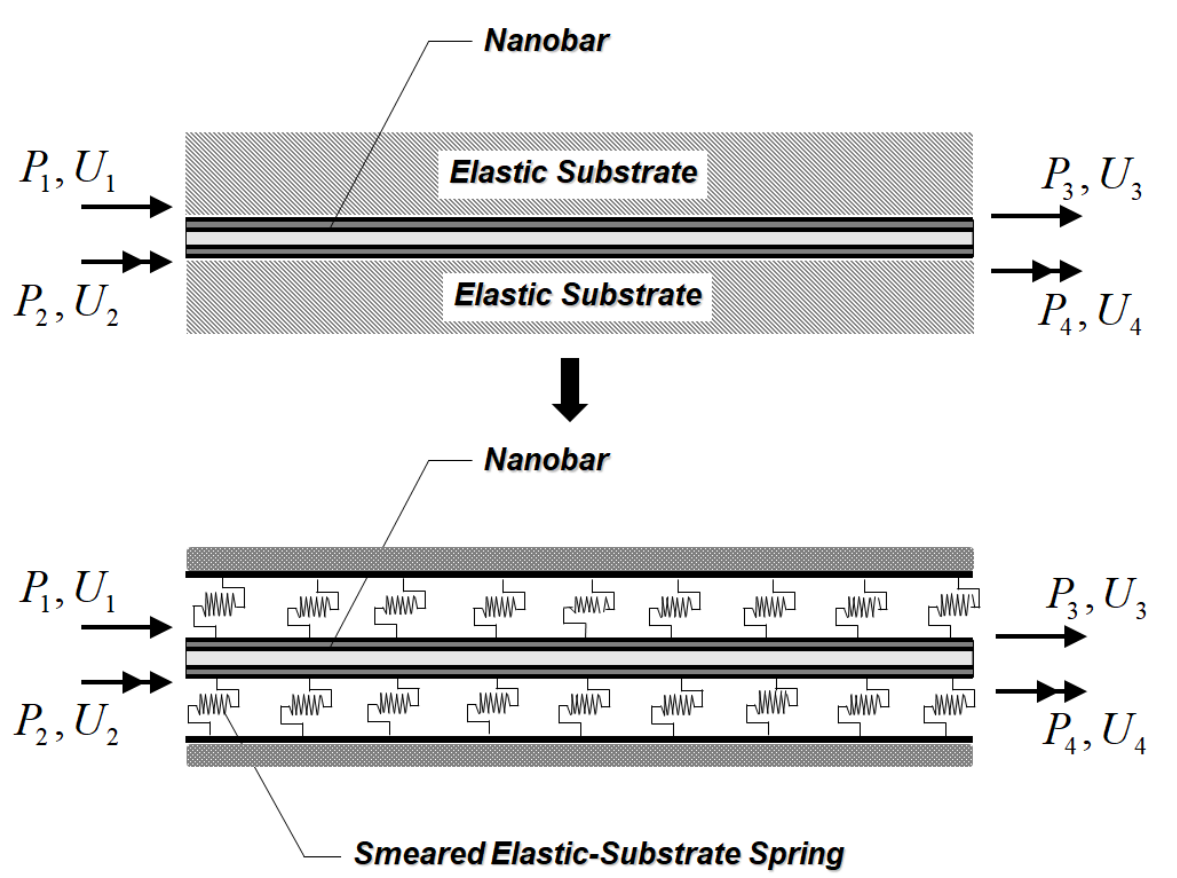
Figure 1. Nanobar–substrate medium Figure 1. Nanobar – substrate medium system.